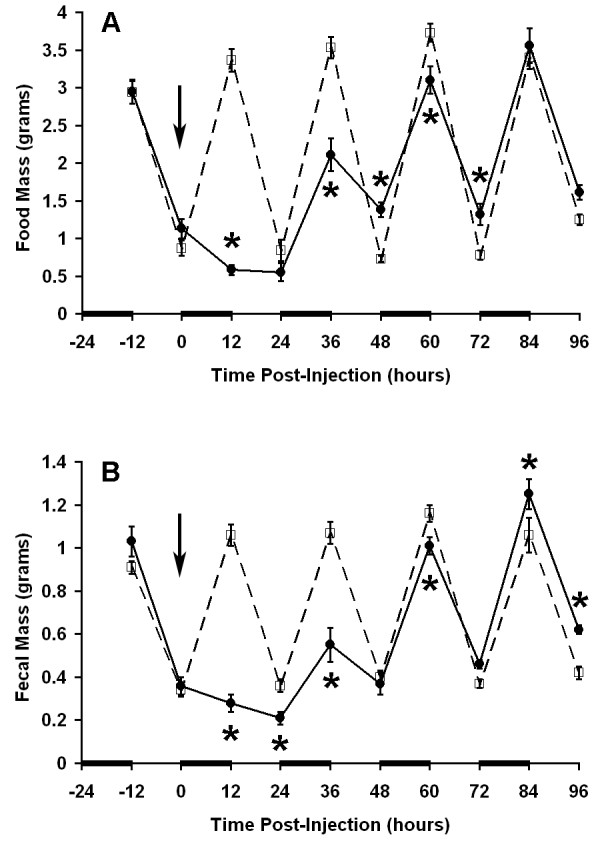
Induction of ileus after endotoxin administration. Measurements were made every 12 hours such that each data point represents the food intake (A) or fecal output (B) corresponding to the preceding scotophase or photophase. Bars along the abscissa indicate scotophase. Endotoxin (0.1 mg/kg, solid line) or carrier (dashed line) was administered by intraperitoneal injection at time 0 (arrow). Data points are presented as mean ± SEM (n = 9 mice per group). * P = 0.02 vs. control at corresponding time point by repeated measures ANOVA and Fisher's PLSD.